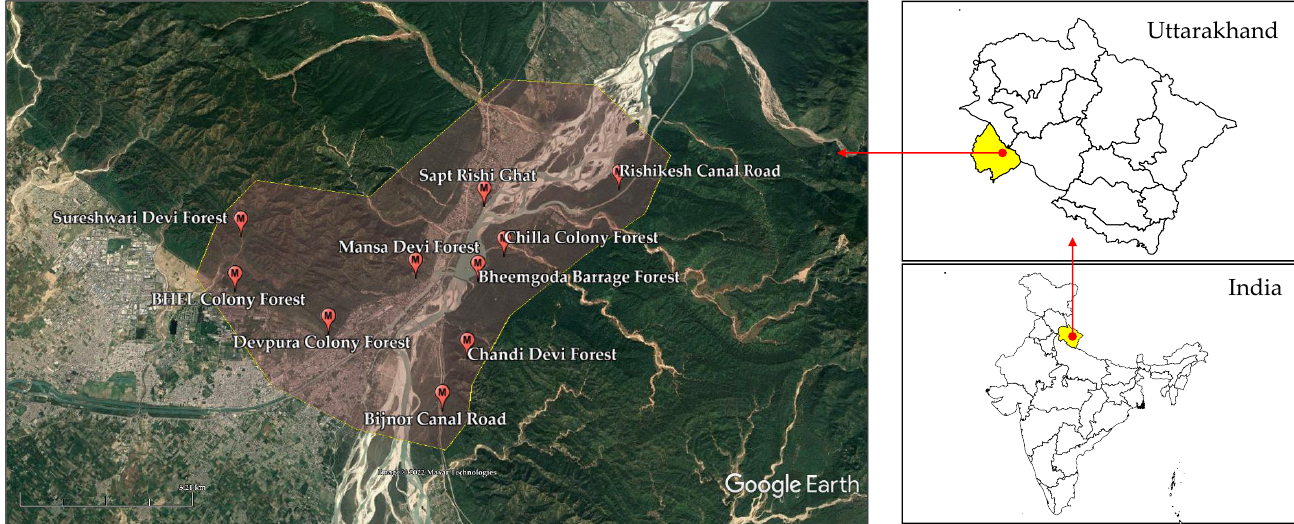
Figure 1. Map showing the sampling locations of Pleurotus spp. collection in and around Rajaji National Park at Haridwar, Uttarakhand, India (Source: Google Earth Pro).